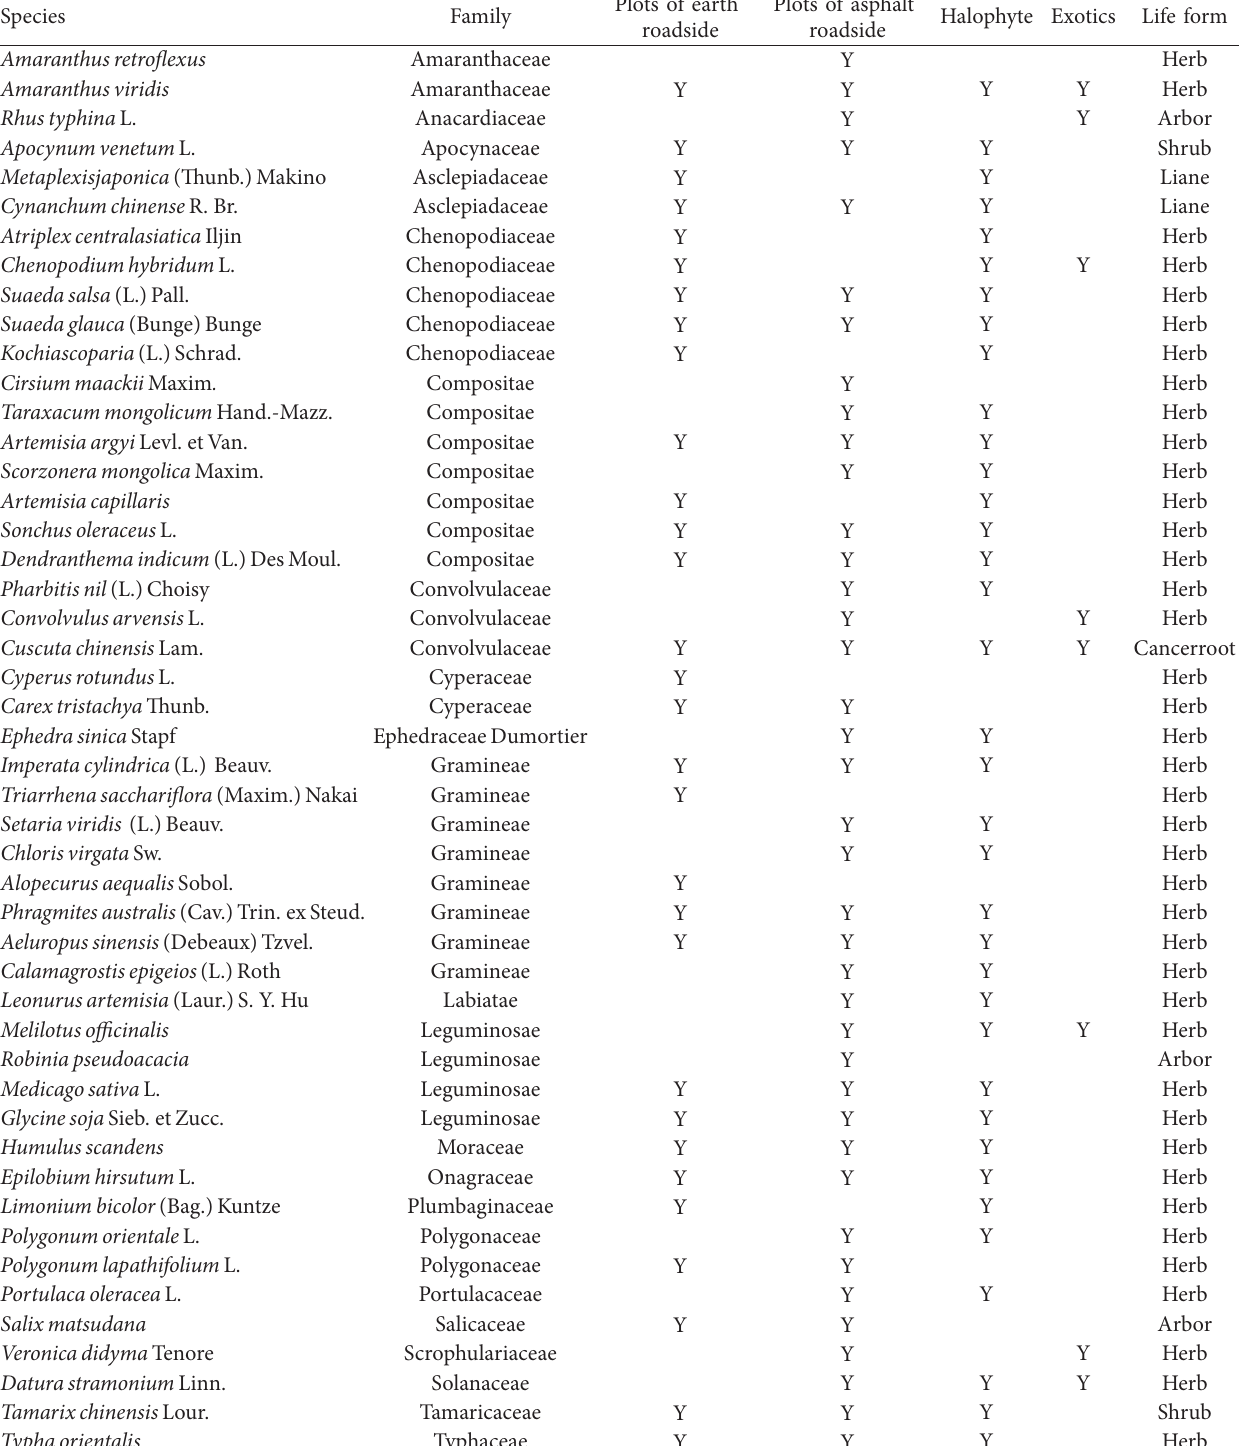
Table 1: List of plant species distributed in roadsides (range of 25 m) of the Yellow River Delta during our investigation. Species